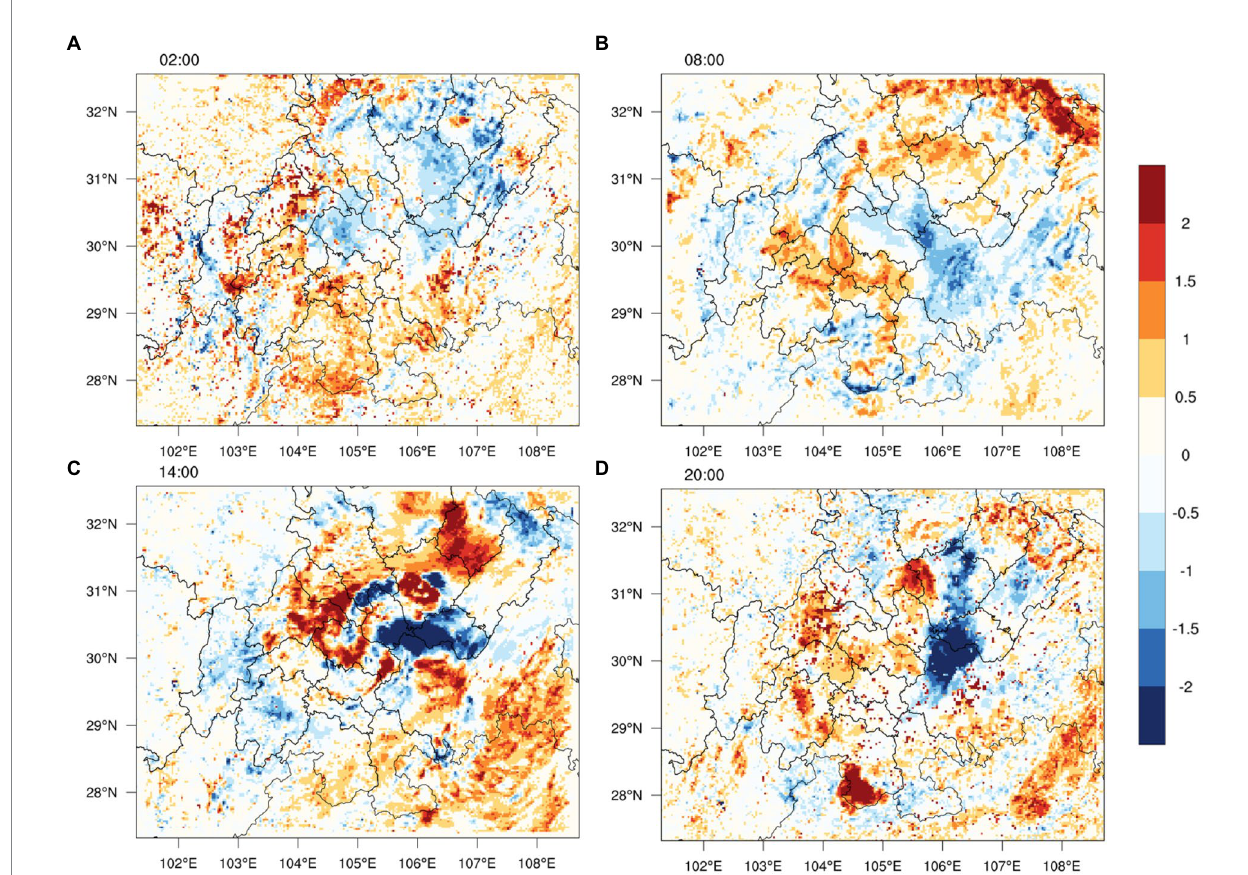
FIGURE 4 Differences in modeled monthly-averaged T2 ( ° C) between 2019LULC and WRF_default scenarios at 02:00, 08:00, 14:00, 20:00 over the SCB in August